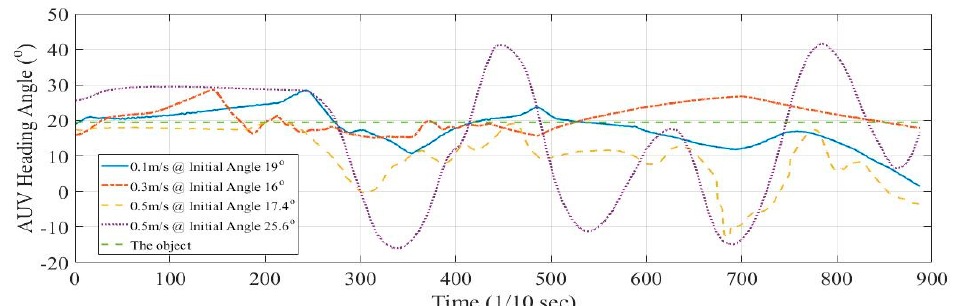
Figure 19. Time histories of AUV heading angles at different target speeds.